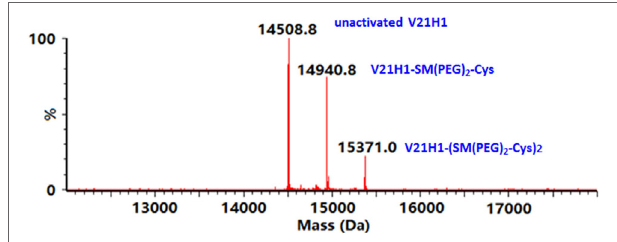
FigUre 2 | Deconvoluted mass spectrum of the V21H1 antibody after activation by cross-linker and linkage to cysteine showing the distribution of non-activated antibody, antibody activated by one cross-linker, and antibody activated by two